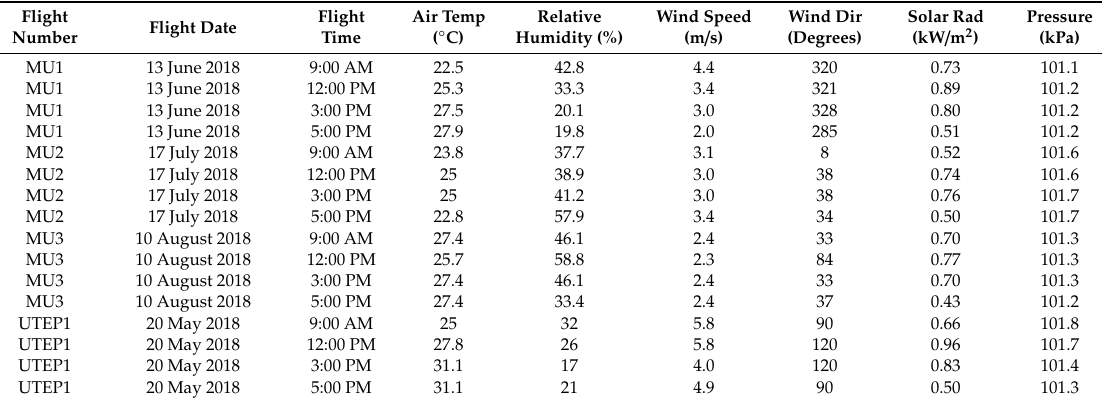
Table 3. Flight log and summary of meteorological variables recorded for Marquette and UTEP during four diurnal